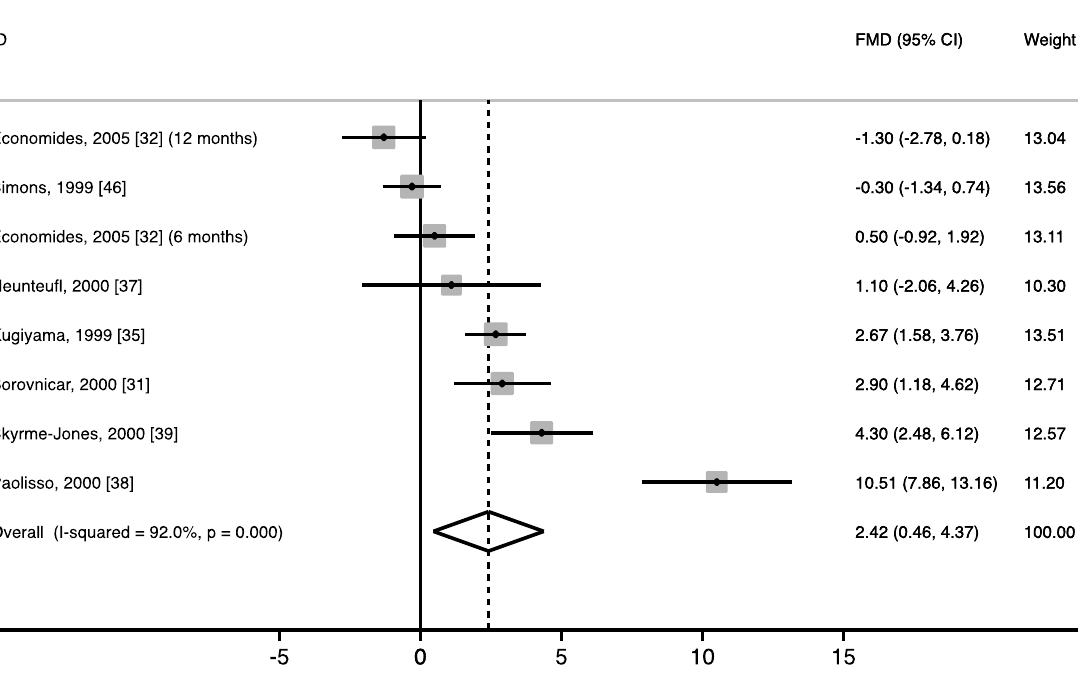
Figure 2. Forest plot of random controlled trials (RCTs) that investigated the effect of vitamin E supplements on flow-mediated vasodilation (FMD). The solid squares represent the weight of individual studies and the diamond represents the weighted mean difference (WMD) in FMD (calculated using random-effect meta-analyses). In all studies combined, vitamin E increased FMD vs . control by 2.42% (95% CI: 0.46% to 4.37%; p = 0.015). After excluding the study by Paolisso and colleagues [38], the overall WMD nearly reached statistical significance (1.38%; 95% CI: −0.12% to 2.87%; p = 0.070). Vitamin D supplementation did not significantly improve fasting FMD of the brachial artery vs